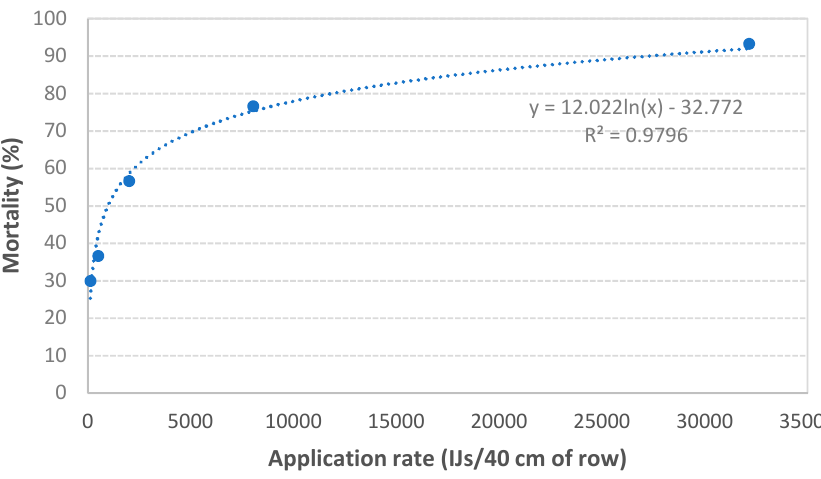
Figure 5. Mortality of Galleria mellonella larvae buried in the soil, by Steinernema rarum (Pam 25) at rates of 125, 502, 2009, 8038 and 32,153 IJs/40 cm of row, two weeks after the application.